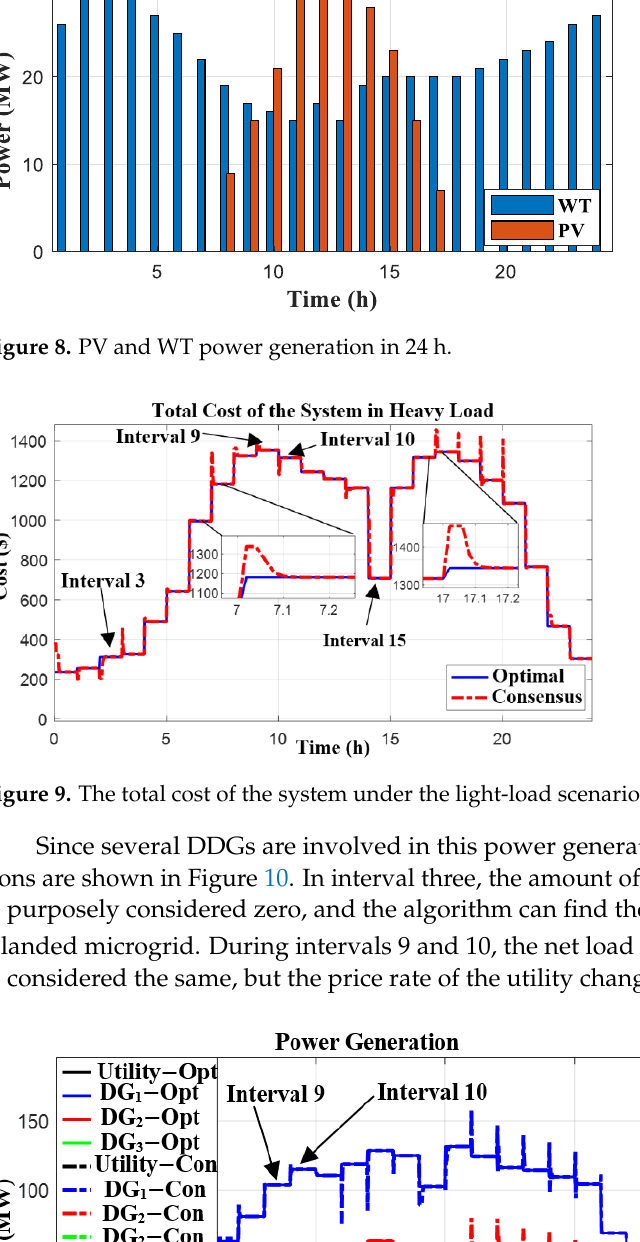
Figure 7. Hourly light load and heavy load profiles.